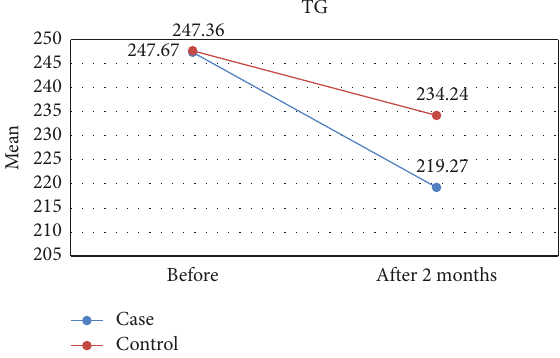
Figure 2: Effect of lycopene supplementation on TG levels. Figure 3: Effect of lycopene supplementation on